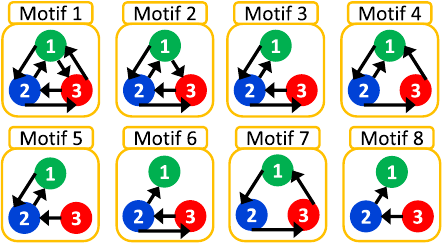
FIG. 1. The eight different 3-node network connection motifs studied.